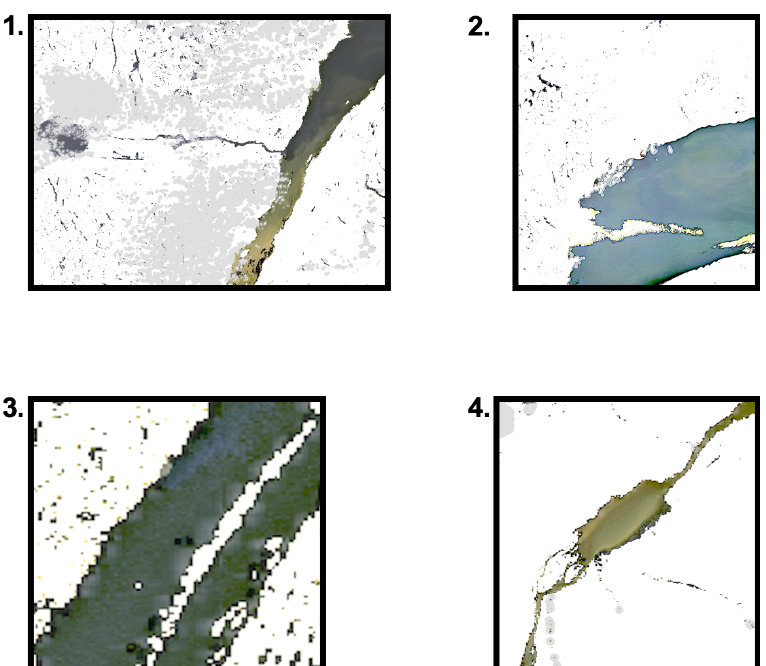
Figure 4. The location of the investigated